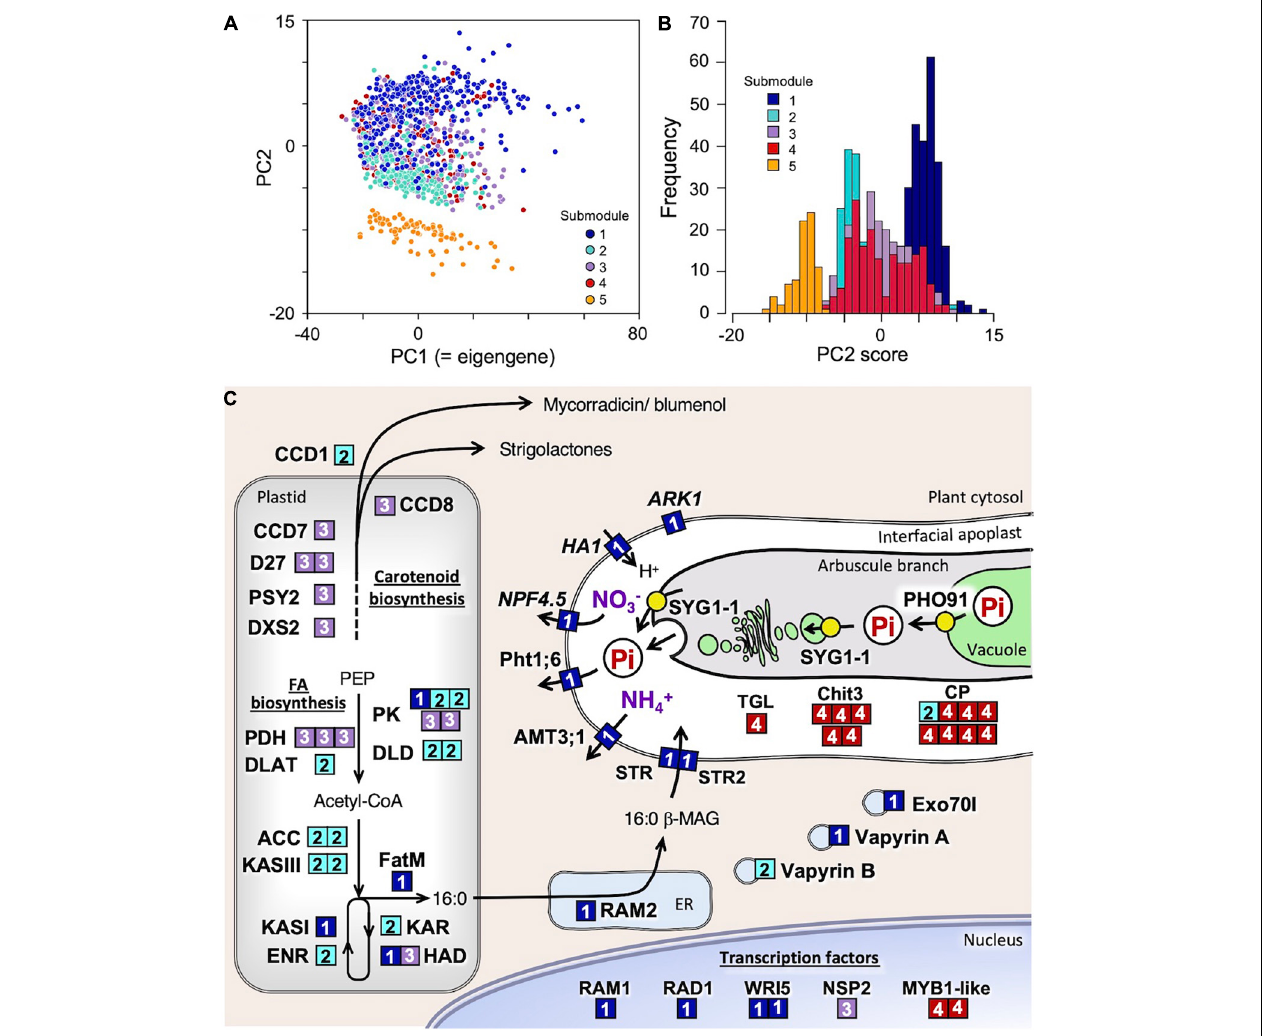
FIGURE 2 | Functional categorization of the 1,023 genes assigned to the mycorrhizal module and into five submodules by k-means clustering analysis using correlation-based distance as a measure. (A) Principal component analysis (PCA) plot of genes in submodules 1–5 and (B) frequency distribution of PC2 score of the genes. (C) Putative function and cellular localization of genes whose orthologs have been functionally characterized in previous studies. The number of the submodule to which the genes belong is indicated in the boxes with same colors in panels (A,B) . No orthologs of the genes in submodule 5 have so far been functionally characterized; thus, they are excluded from this